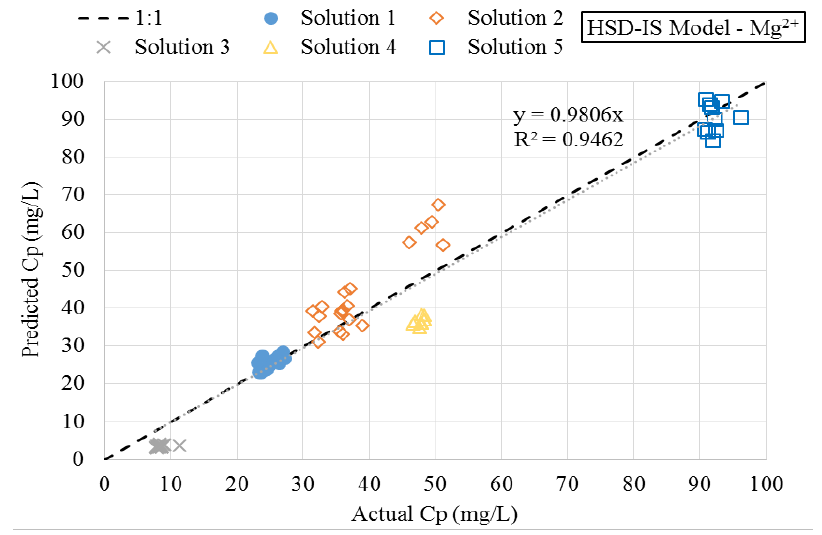
Figure 8. Predicted versus actual magnesium permeate concentration using HSD-IS model.